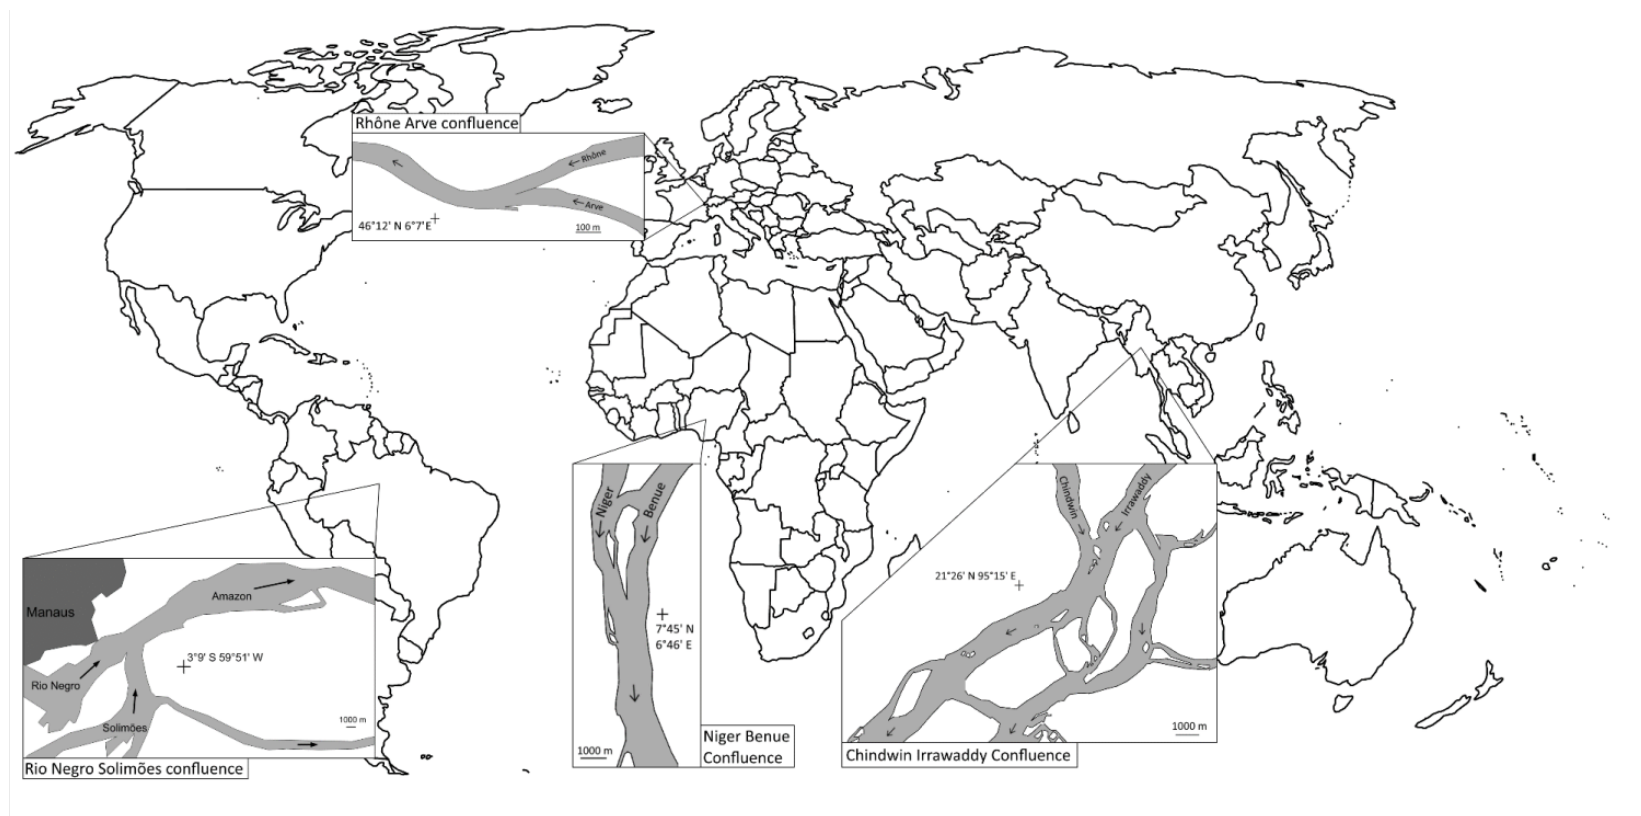
Figure 5. Map showing the locations of the studied confluences, with zoomed in maps for each